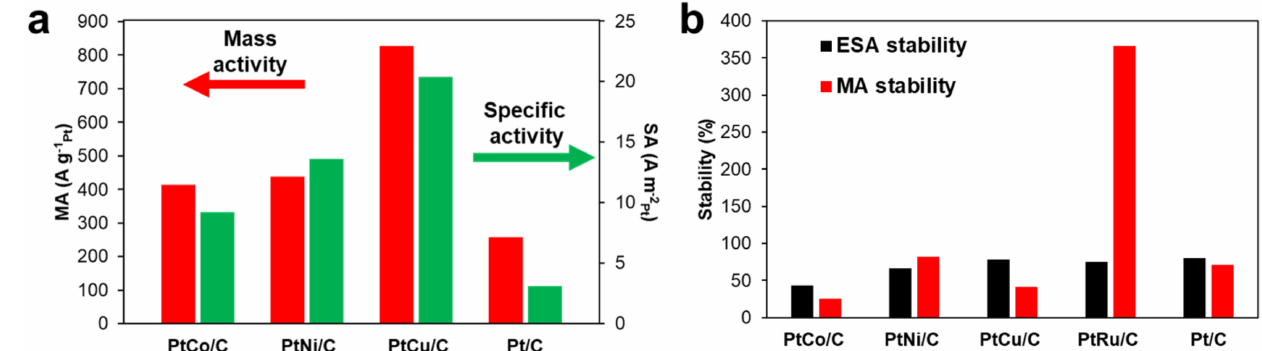
Figure 6. The mass (red bars) and specific (green bars) ORR activities of the bimetallic catalysts ( a ); the relative stability of the catalysts during the AST calculated from the change in the ESA (black bars) and the mass activity in the ORR (red bars) ( b ).